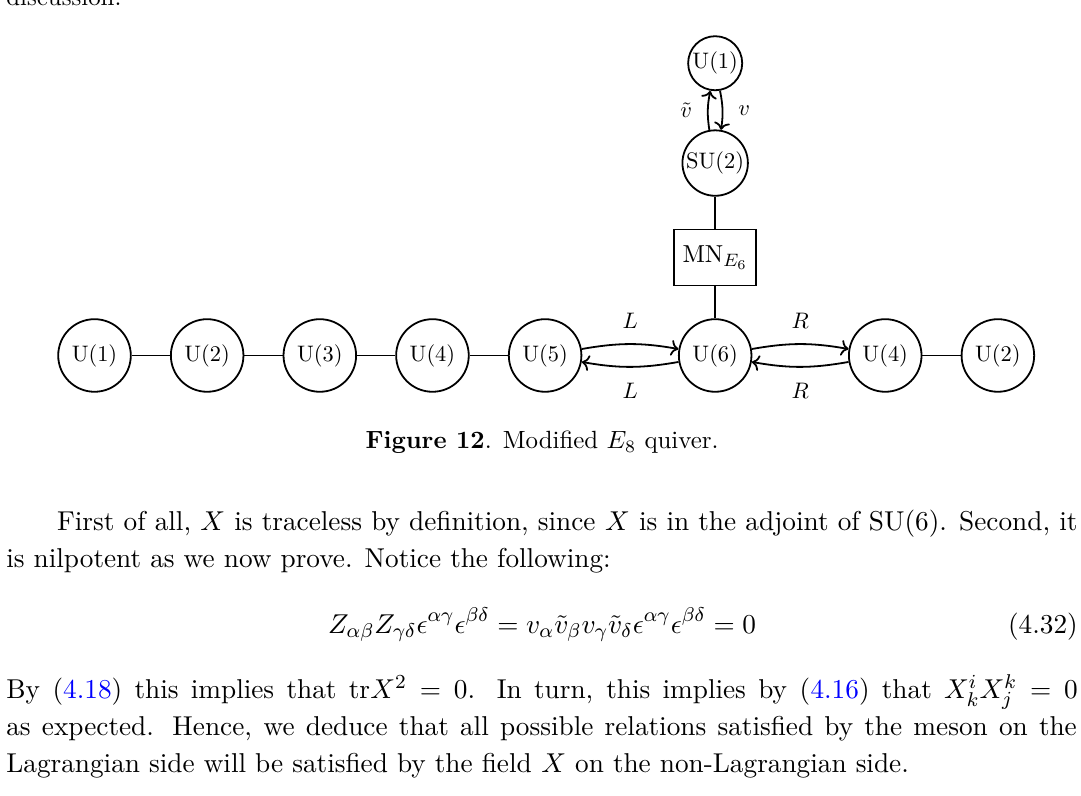
Figure 11 . E 8 quiver. We show the double arrows between the nodes only when relevant for our discussion.